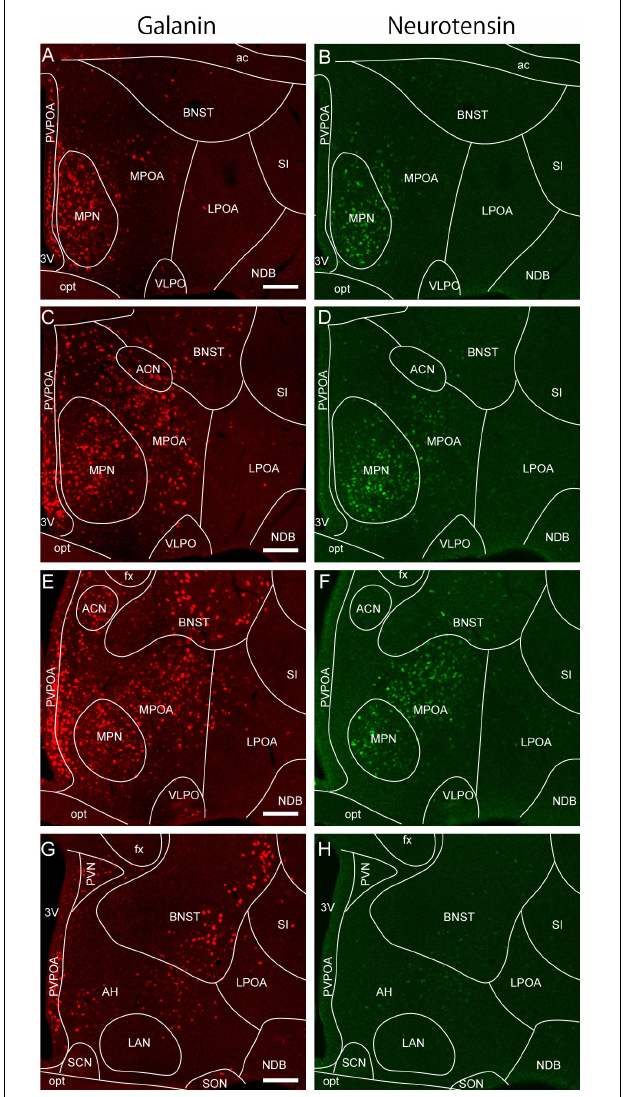
FIGURE 2 | Galanin and neurotensin mRNA expression in the preoptic area. (A,B) Double ISH for (A) galanin and (B) neurotensin of a coronal section of the mouse brain (bregma + 0.10 mm). (C,D) Double ISH for (C) galanin and (D) neurotensin of a coronal section of the mouse brain (bregma –0.02 mm). (E,F) Double ISH for (E) galanin and (F) neurotensin of a coronal section of the mouse brain (bregma, –0.14 mm). (G,H) Double ISH for (G) galanin and (H) neurotensin of a coronal section of the mouse brain (bregma, –0.24 mm). Scale bars: 200 µ m. 3v, third ventricle; ac, anterior commissure; ACN, anterior commissural nucleus; AH, anterior hypothalamus; BNST, bed nucleus of the stria terminalis; fx, fornix; LAN, lateroanterior hypothalamic nucleus LPOA, lateral preoptic area; MPOA, medial preoptic area; MPN, medial preoptic nucleus; NDB, nucleus of the diagonal band; opt, optic tract; PVPOA, periventricular preoptic area; SCN, suprachiasmatic nucleus; SI, substantia innominata; SON, supraoptic nucleus; VLPO, ventrolateral preoptic nucleus. Adapted from Tsuneoka et al.